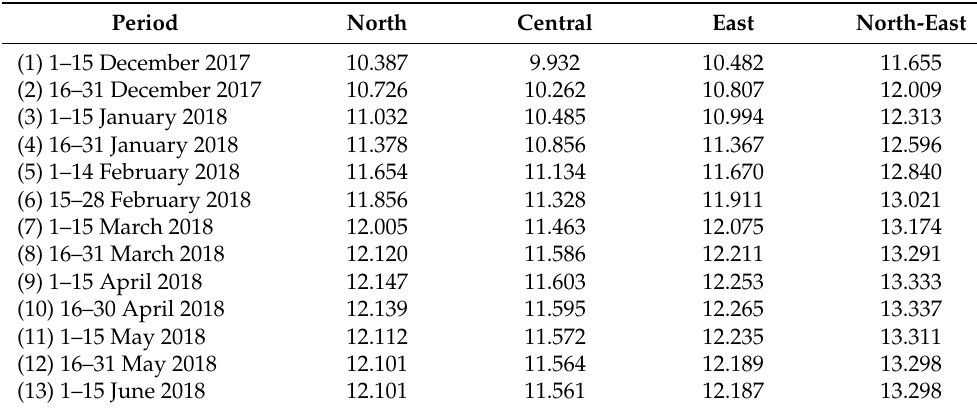
Table 2. The Commercial Cane Sugar System (CCS) value in each region for crop year 2017/18.